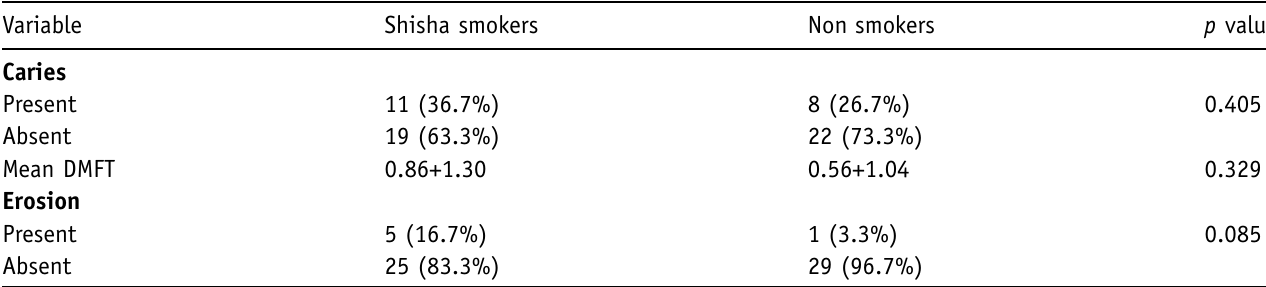
Table III. Comparison of erosion and dental caries experience among shisha smokers and non-smokers Variable